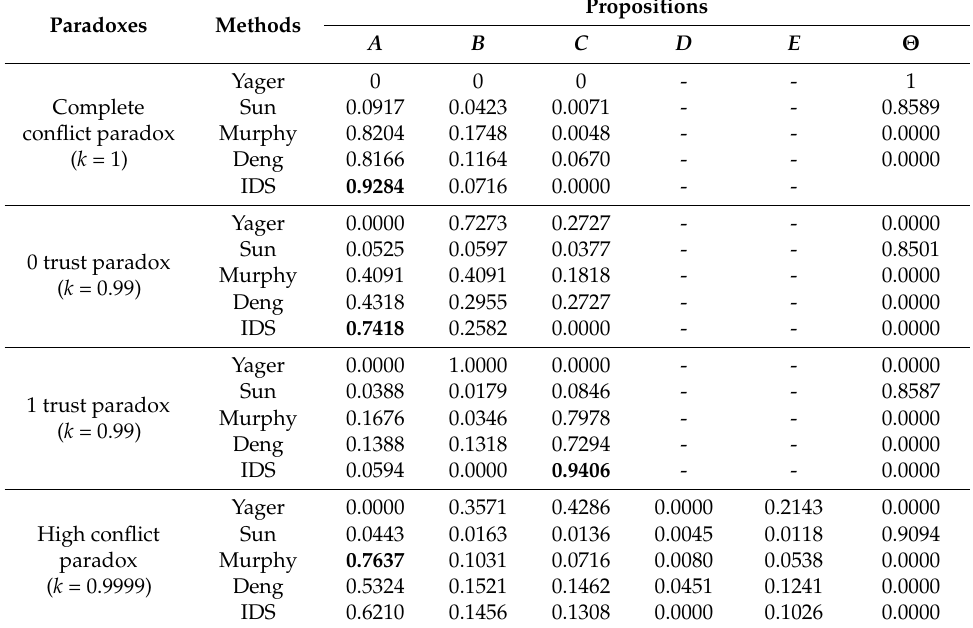
Table 4. Comparison of the synthesis